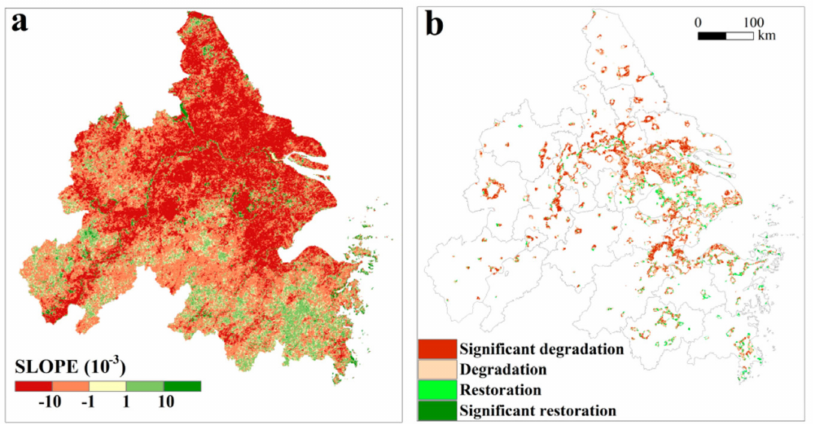
Figure 19. Trends of vegetation change in ( a ) YRDUA and ( b ) urban sprawl area in 2004–2013. Source: